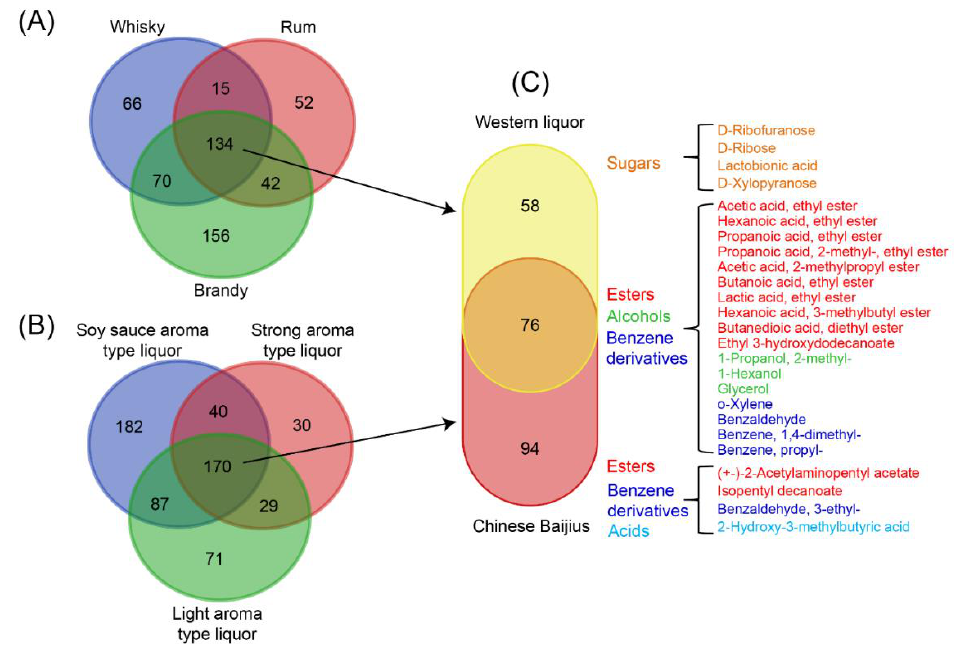
Figure 4. Venn diagram showing the similarities and differences of chemical composition between Chinese baijius and Western liquors. Number of unique and common compounds in ( A ) Western liquors and ( B ) Chinses baijius, and ( C ) the number of unique and common compounds between Western liquors and Chinese baijius. The listed compounds were distinct/shared compounds in Chinese baijius and Western liquors with concentrations more than 1 mg/L in most samples. Information about concentrations of the compounds in this figure can be found in Supplementary